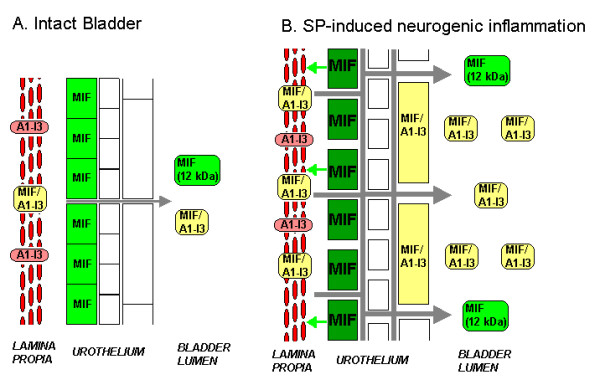
Model of MIF/A1-I3 complex formation and paracellular transport through the urothelium. In the intact bladder (A), A1-I3 (not synthesized by the bladder and most likely of liver origin) is located in the lamina propria immediately below the urothelium and throughout the interstitial spaces in the bladder. MIF is found in the urothelium, in the basal and intermediate cells. The lamina propia shows only weak MIF immunostaining. There is basal MIF release (and MIF/A1-I3 complexes) into the bladder lumen, however, A1-I3 is not located in the urothelium of intact rats. After SP-induced neurogenic inflammation (B), there is upregulation of MIF production in the urothelium, increased MIF staining in the lamina propria and greater release of MIF and MIF/A1-I3 complexes. Paracellular transport of A1-I3 can be observed in the urothelium. In addition, apical (umbrella cells) are now observed co-localizing both MIF and A1-I3.